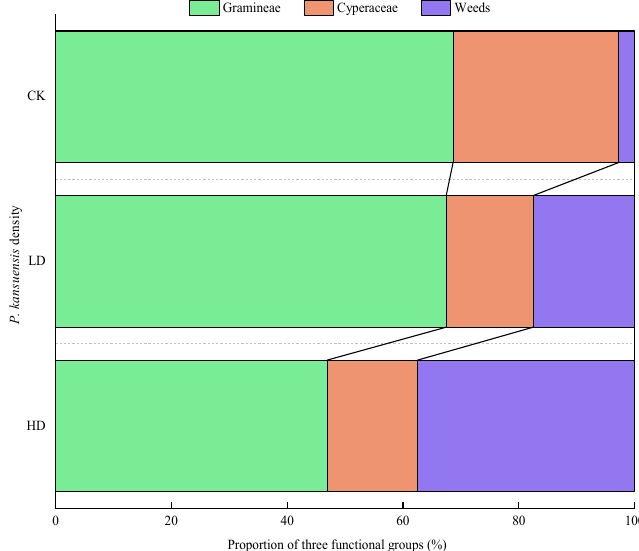
Figure 4. The ABR of different functional groups of P. kansuensis patches in different densities.